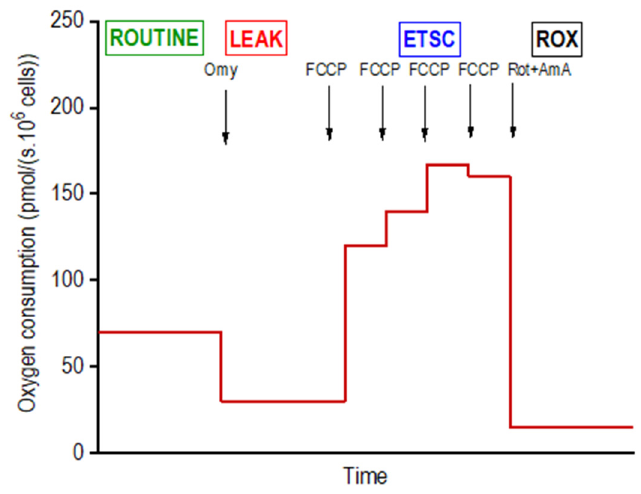
Figure 2. Design of a titration protocol for measuring the mitochondrial oxygen consumption in intact differentiating adipocytes. For the concentrations of inhibitors and uncoupler utilized and definition of respiratory states, see Methods.